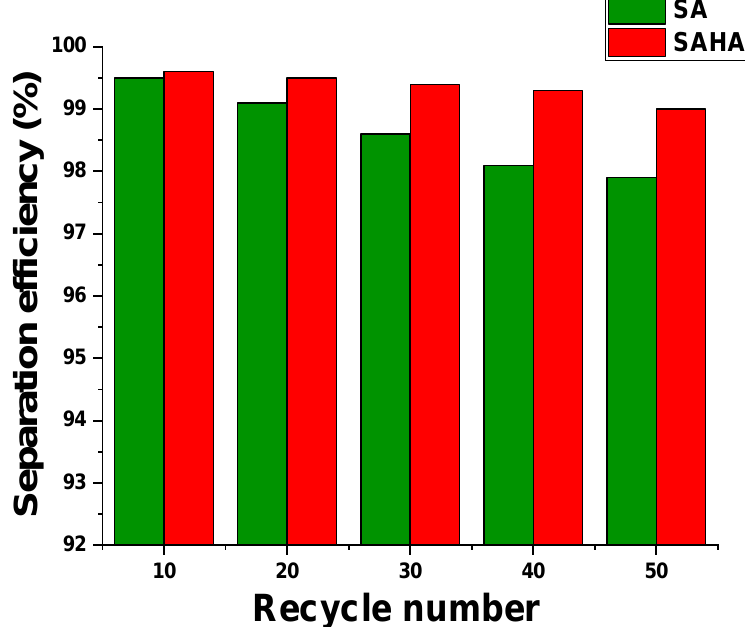
Figure 11. Separation e ffi ciency versus recycle numbers (corn oil / water mixture as sewage).